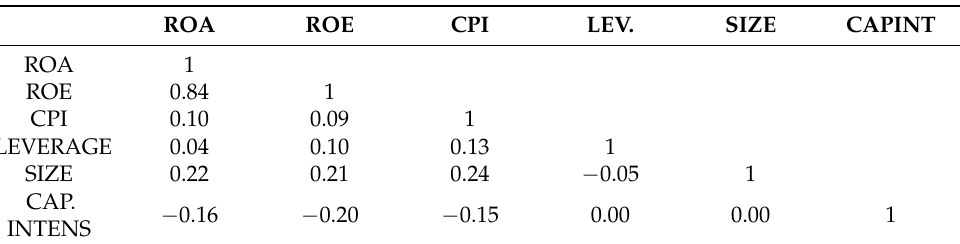
Table 8. Correlation matrix.